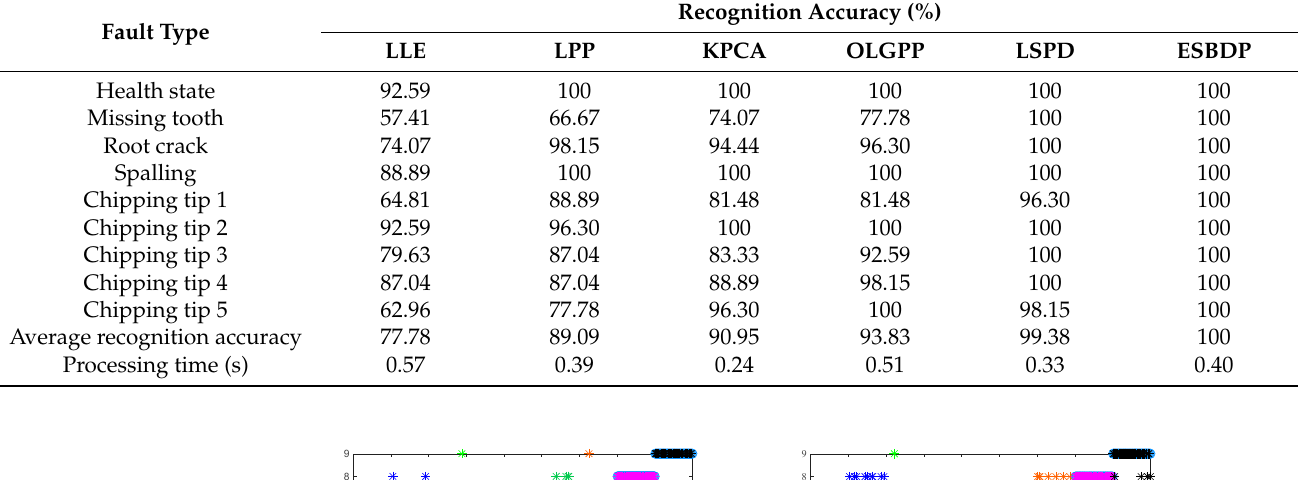
Table 4. Fault recognition accuracy of gear dataset processed by different method.